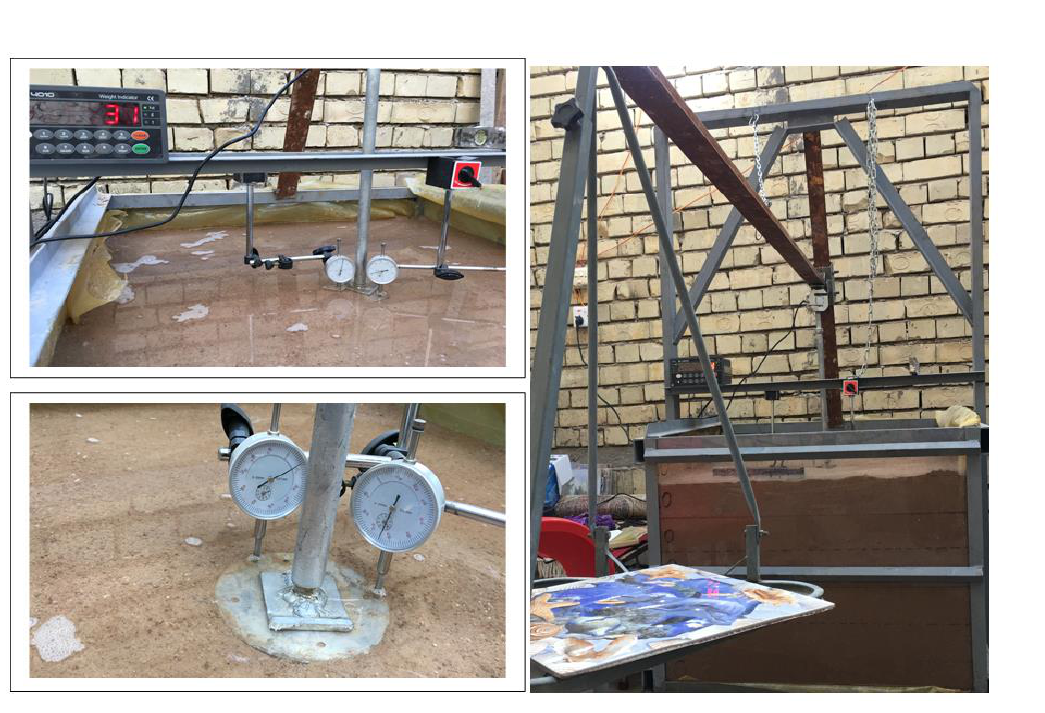
Fig. 4. Saturated soil Prepared for model test with applied the first load